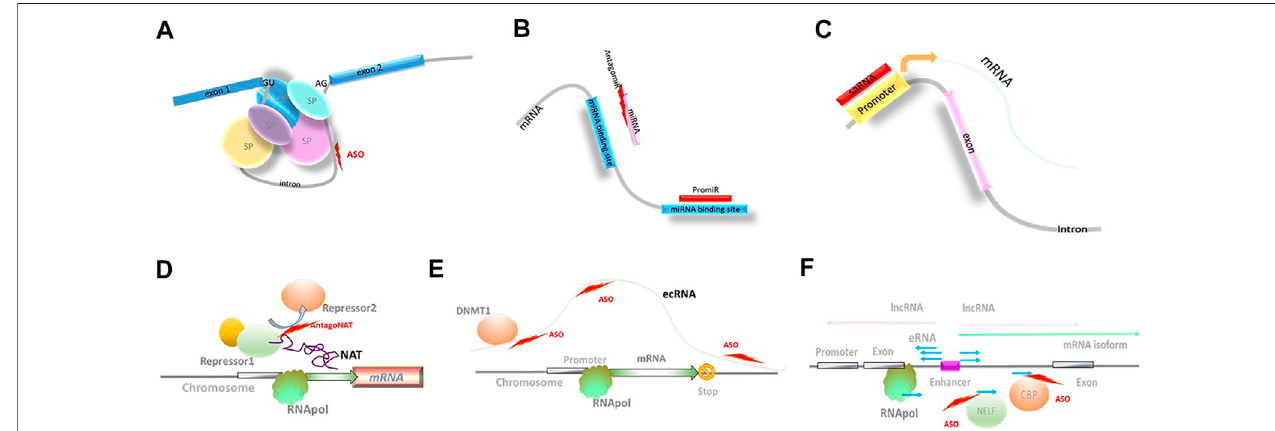
FIGURE 2 | Novel biological mechanisms accessible through NBTs. (A) Modulation of splicing; SP: spliceosome components; ASO: antisense oligonucleotides. (B) Modulation of miRNA activity. (C) Small activating RNAs (saRNA). (D) Modulation of natural antisense transcript (NAT) activity; RNApol: RNA polymerase. (E) Extra- codingRNA(ecRNA);DNMT1:DNAmethyltransferase1. (F) EnhancerRNAs(eRNA);negativeelongationfactorcomplex(NELF);CBP:histoneacetyltransferaseCREB- binding